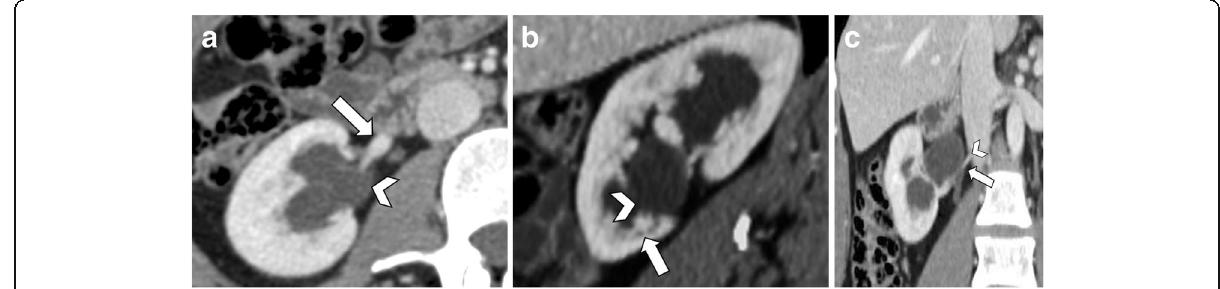
Fig. 13 A 31-year-old woman with ureteropelvic junction obstruction. a Axial CT image shows pelvic dilatation (arrowhead) caused by ureteropelvic junction compression by lower pole segmental renal artery (arrow). b The image reconstructed through an oblique sagittal plane, known as “ hilar clock-face view ” , obtained orthogonal to the renal hilum, shows the relationship between the lower pole segmental renal artery (arrow) and the ureteropelvic junction (arrowhead). c Coronal CT image on the portal venous phase shows the ureteropelvic junction compressed (arrow) by lower pole segmental renal artery originating from the abdominal aorta